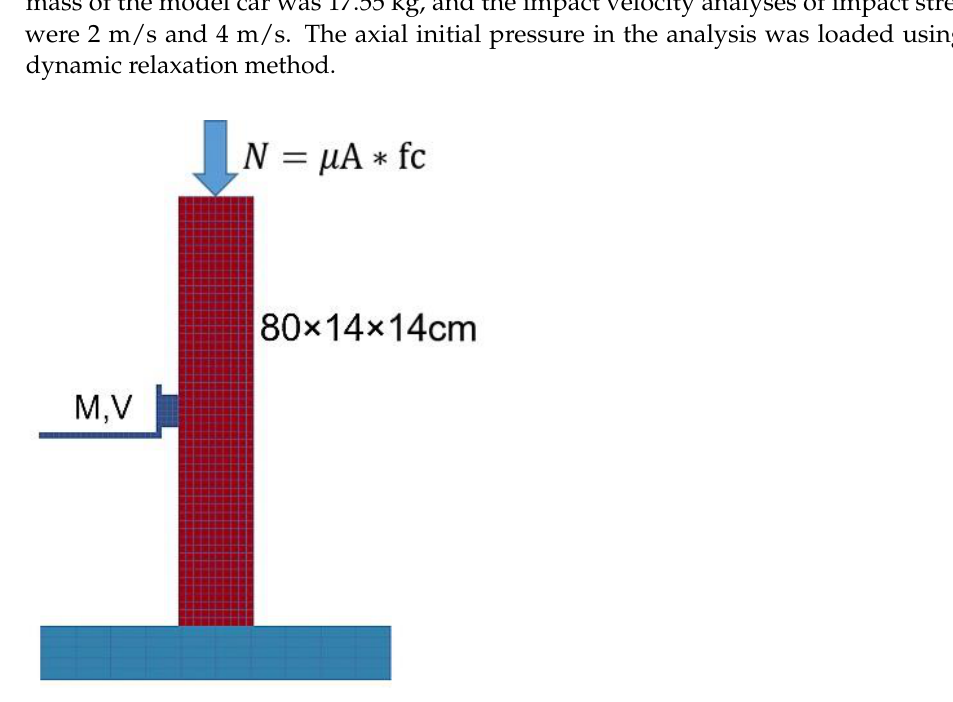
( b ) Figure 24. Comparison of RCCs with different slenderness ratios: ( a ) comparison of column top displacement; ( b ) comparison of column displacement angle. 5.5. Effect of Axial Compression Ratio Two perspectives can be used to analyze how the axial compression ratio affects the impact resistance of RCCs. On the one hand, the impact resistance and damage failure mode of a column section are impacted by the second-order effect of axial force. On the other hand, the contact interface force time history is somewhat impacted by variations in the axial compression ratio and the contact stiffness between the impact body and the column impact contact area. However, there are differences in existing research conclusions. He Su et al. [28] used an MTS dynamic-loading device to carry out the multipoint loading of RCC lateral impact loads and studied the effect of the axial compression ratio. The specimen lateral displacement increased with increase in the axial compression ratio at the same loading rate. Huijia Wang [29] conducted a shear failure test of 30 reinforced concrete beams. It was concluded that the shear resistance varied with the axial compression ratio. When the axial compression ratio was less than 0.4 – 0.5, the